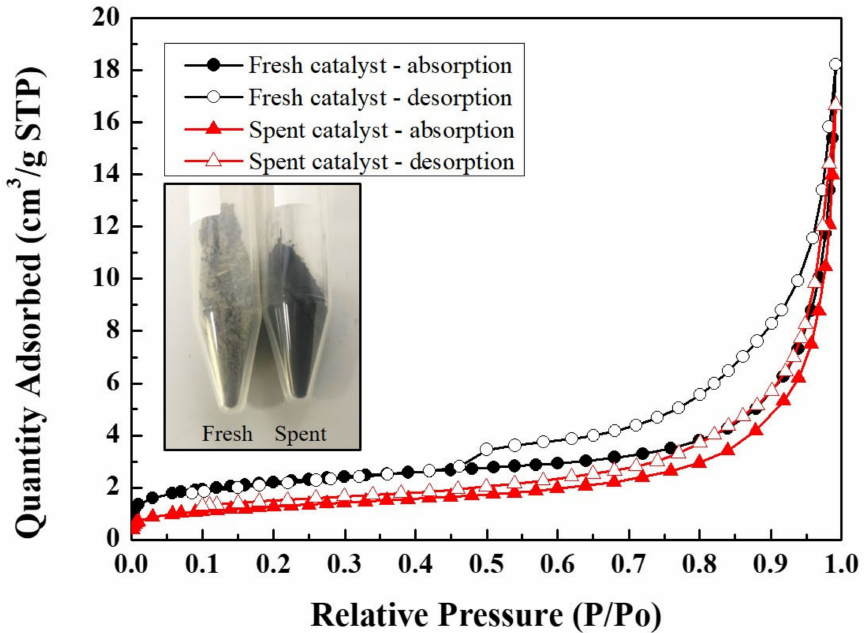
Figure 4. Adsorption–desorption isotherms of N 2 at 77K for the fresh and spent catalysts.